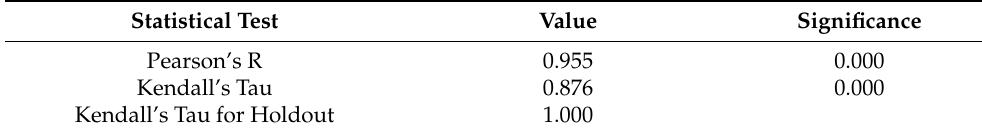
Table 7. Summary of Statistical